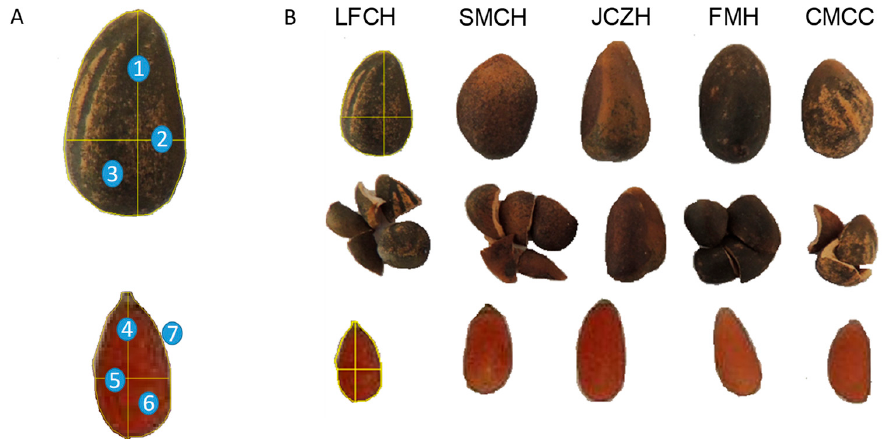
Figure 5. Morphology of the pine nut of P. cembroides . ( A ) Intact seed used to determine the weight of the seed. 1 = Vertical line used for the determination of the seed length. 2 = Horizontal line that represents the measurement used to determine the width of the seed. 3 = Measurement of the seed area. In the lower part, an intact scarified seed used to determine the weight of the megagametophyte. 4 = Vertical line used for megagametophyte length determination. 5 = Horizontal line that represents the measurement used to determine the width of megagametophyte. 6 = Area of megagametophyte. 7 = Perimeter of megagametophyte. ( B ) Morphology of the intact seed of La Florida, Cardonal (LFCH), San Miguel Tlazintla, Cardonal (SMCH), Jagüey Colorado, Zimapán (JCZH), Fontezuelas, Metztitlán (FMH), Malpaso Curves, Cuauhtémoc (CMCC). The intermediate part represents the seed coat and the lower part of the scarified seed.